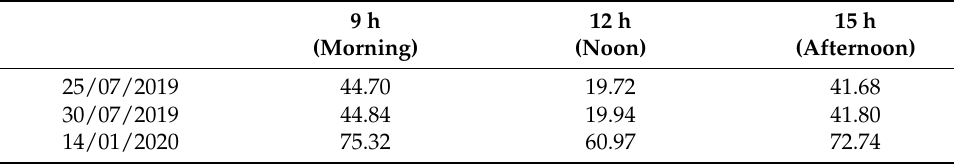
Table 2. Solar zenith angle (SZA), in degrees, for the studied